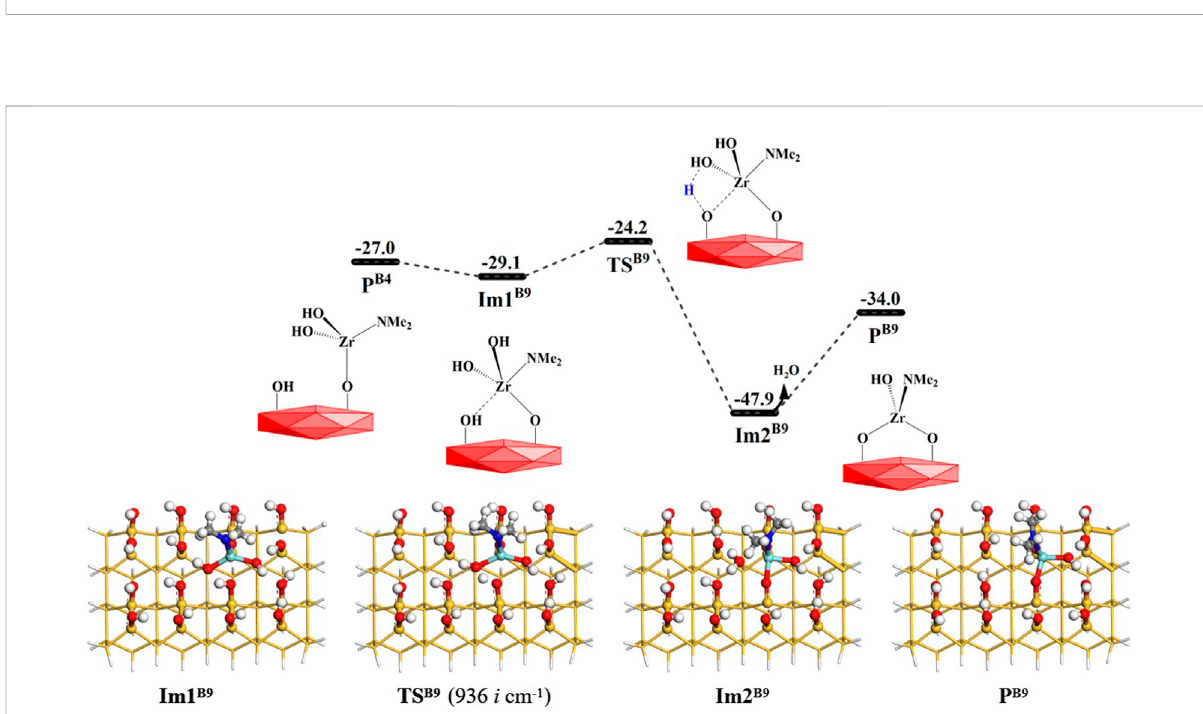
FIGURE 13 Gibbs free energy ( Δ G , kcal/mol) pro fi les of the B9 section of the H 2 O reaction with the aminated surface.